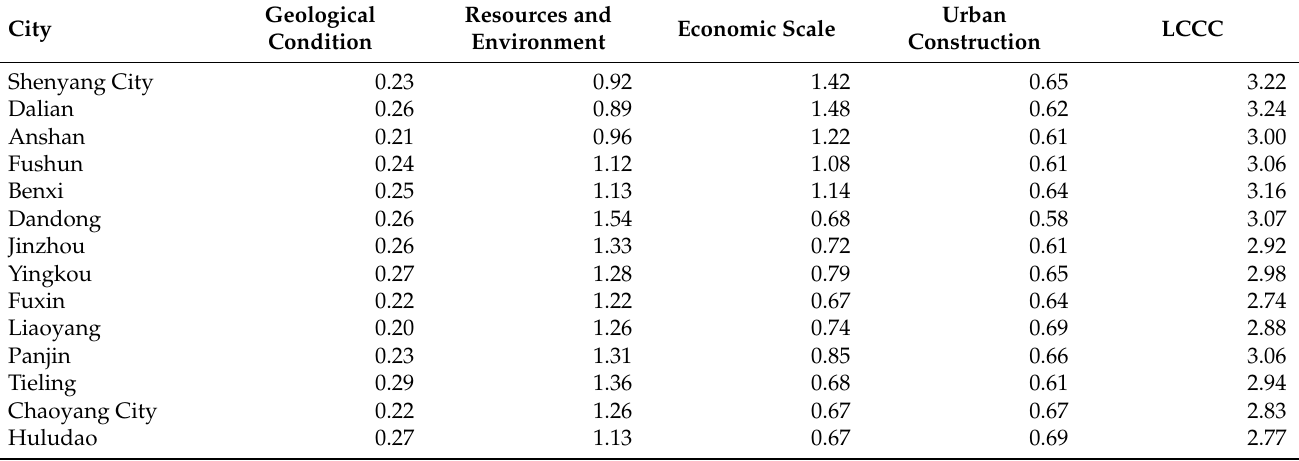
Table 4. Evaluation index of LCCC in Liaoning